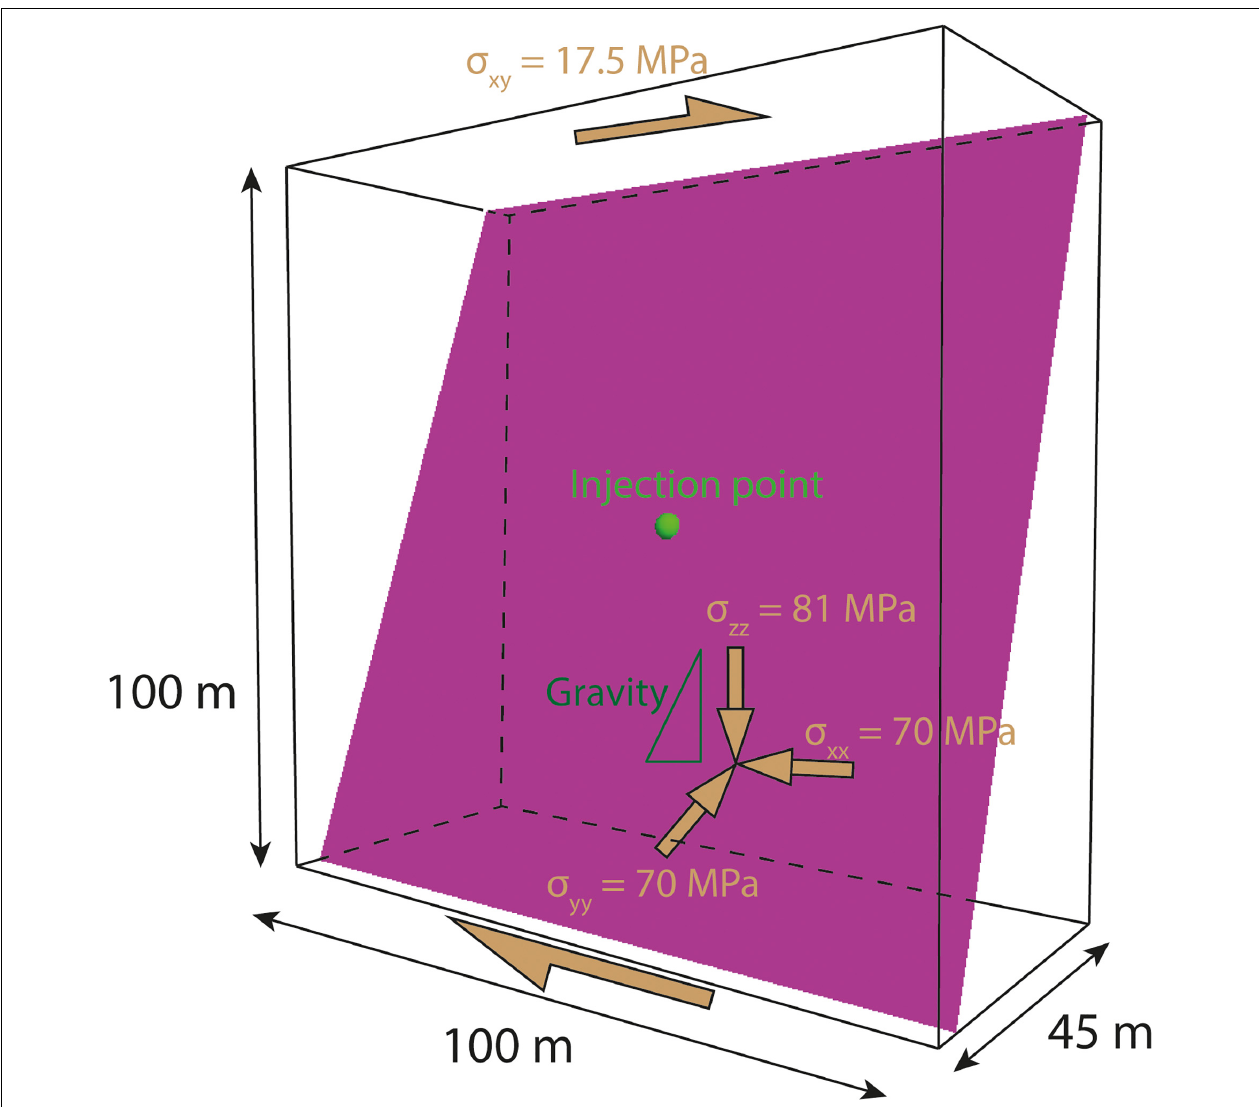
FIGURE 1 | 3D model geometry of the 70 ◦ dipping fault represented in purple and the injection point in light green at the center of the fault. The initial state of stress has a vertical ( σ zz ) and horizontal ( σ xx and σ yy ) stresses, plus a deviatoric component ( σ xy ) to simulate dominantly strike-slip stress regime. The gradient of stress with depth and gravity is indicated as a dark green triangle that gets larger